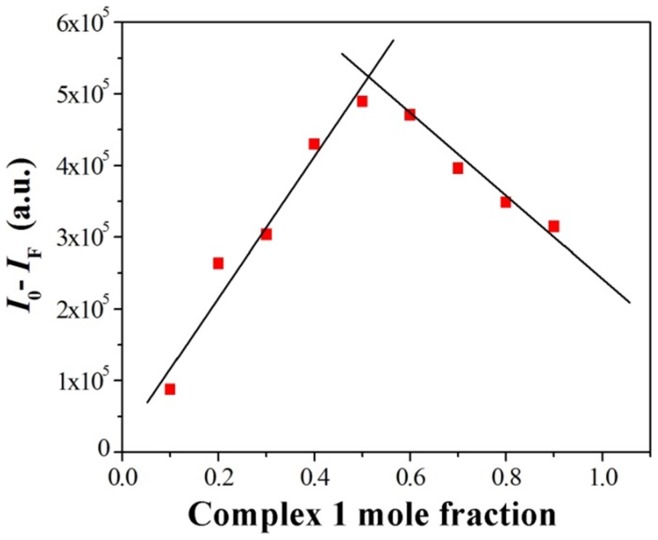
Job's plot analysis of luminescence titration data for 1 in CH3CN solution.The total concentration of 1 and Cu2+ is 1 µM. λex = 355 nm, λem = 560 nm.